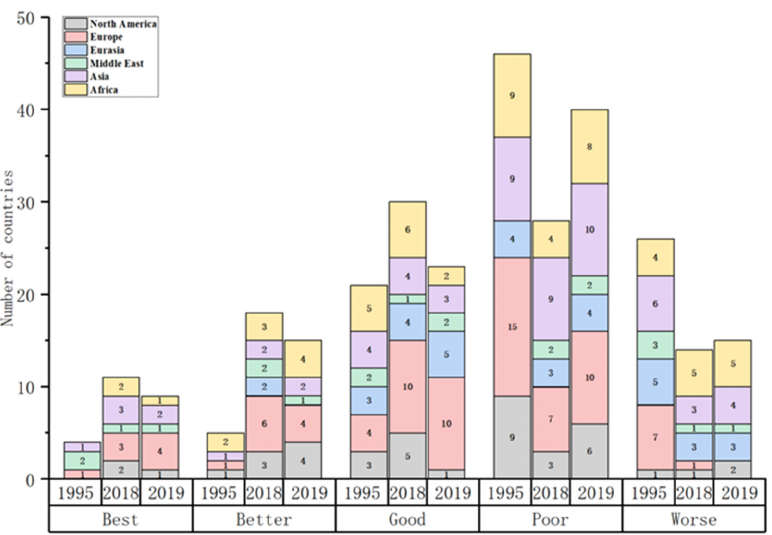
Figure 2. The dynamic evolution of global energy security.